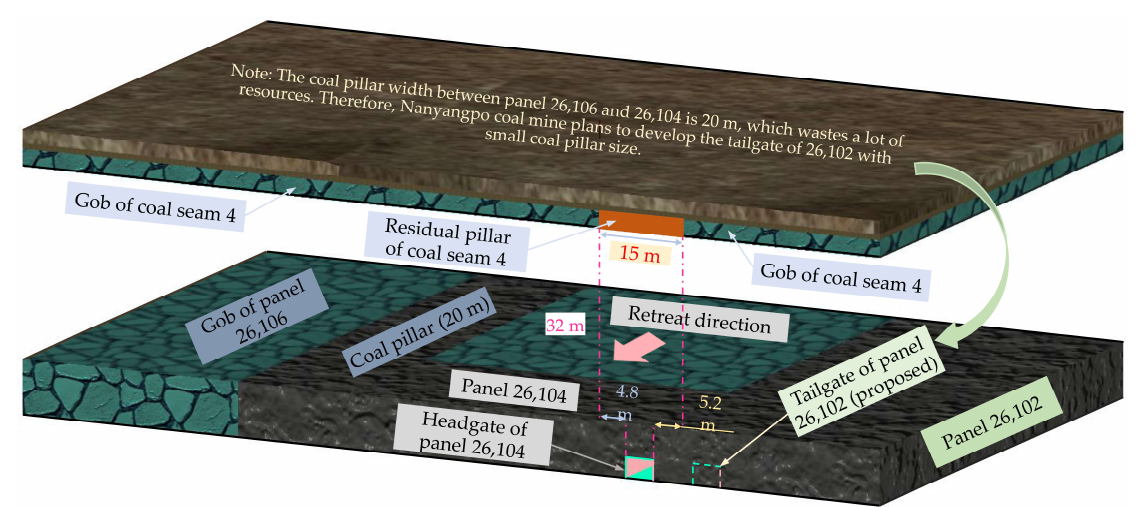
Figure 2. Detailed panel layout of the test site.